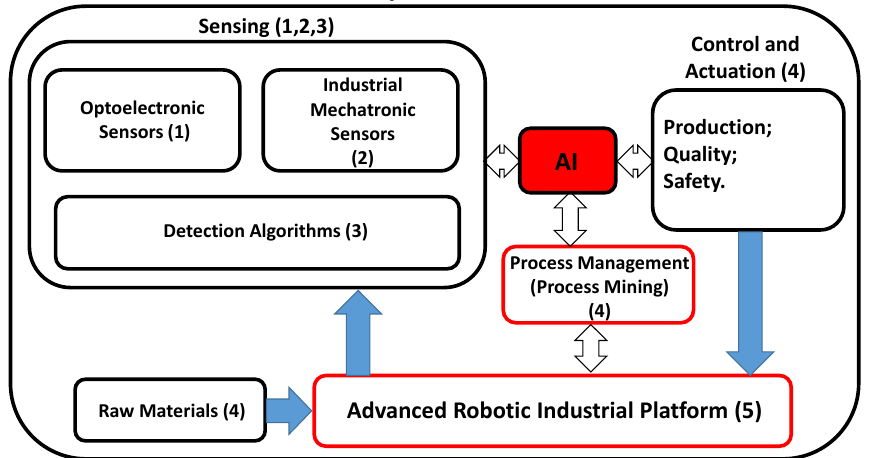
Figure 1. Industry 5.0 framework of the topics of this review structured in fi ve main di ff erent blocks.